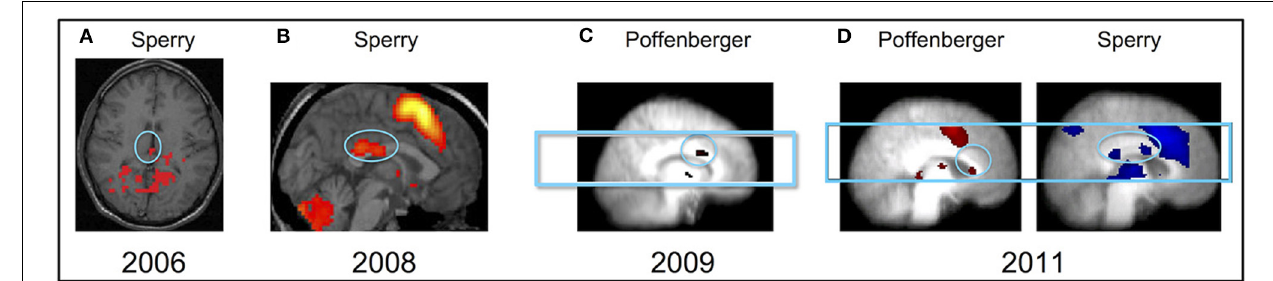
FIGURE 2 | Examples of white matter fMRI activation from studies published in 2006-2011. (A) An exploratory study of white matter activation by D’Arcy et al. in 2006 used a Sperry interhemispheric transfer task and detected activation near the splenium of the corpus callosum. This initial study led to (B) a prospective study of fMRI activation in white matter, which used a similar task and also revealed activation in the posterior corpus callosum. A follow up study, (C) aimed to improve sensitivity to the detection of white matter fMRI